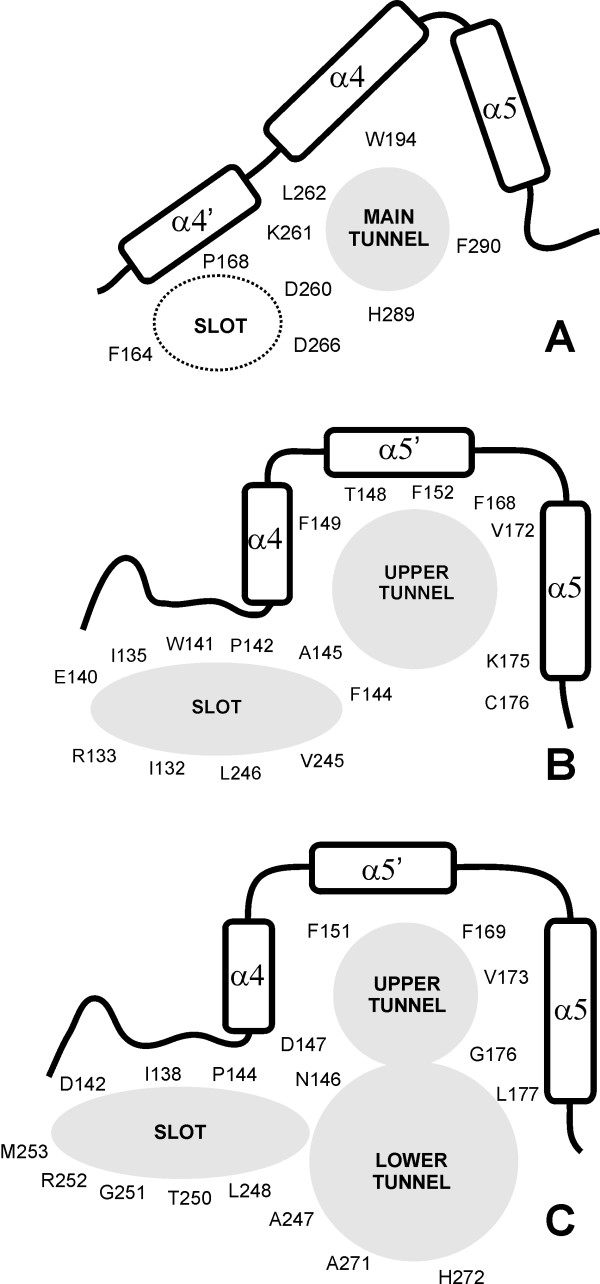
Scheme of haloalkane dehalogenases' tunnels. Schematic representation of access paths for DhlA (A), DhaA (B) and LinB (C) identified by protein crystallography [19–31] and molecular dynamic simulations [32]. The slot in DhlA was described in this study.